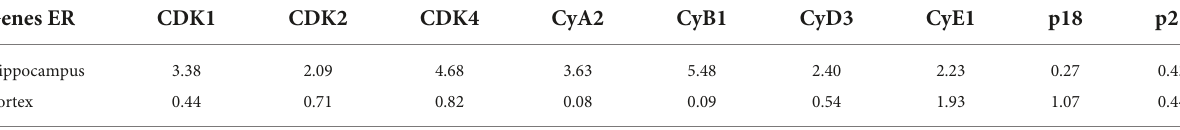
TABLE 3 The expression of cell cycle-associated genes in the brains of 3-month-old APP/PS1 mice. Genes ER Hippocampus